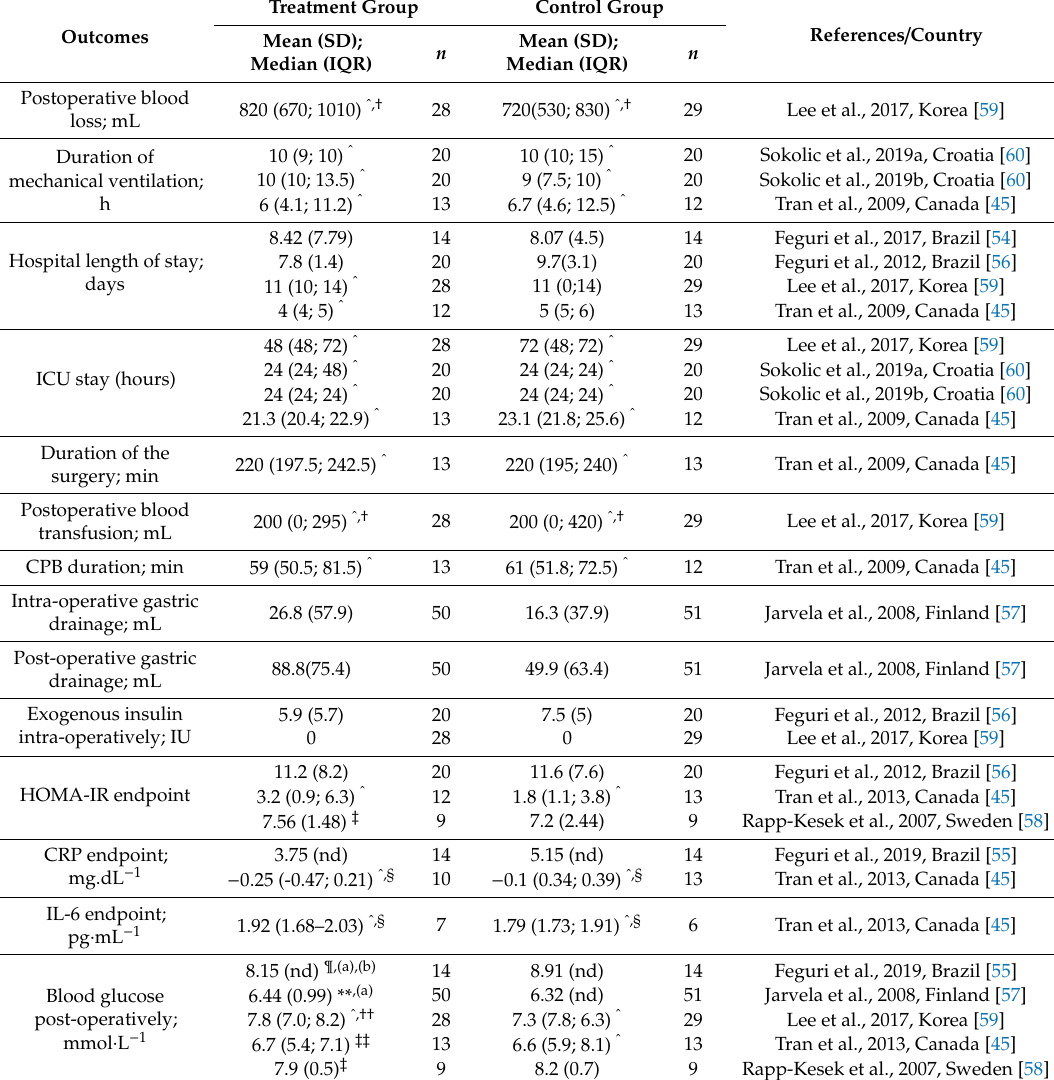
Table 3. Quantitative clinical outcomes that were not subjected to meta-analysis. Values are mean (standard deviation (SD)) or median (interquartile range (IQR)).